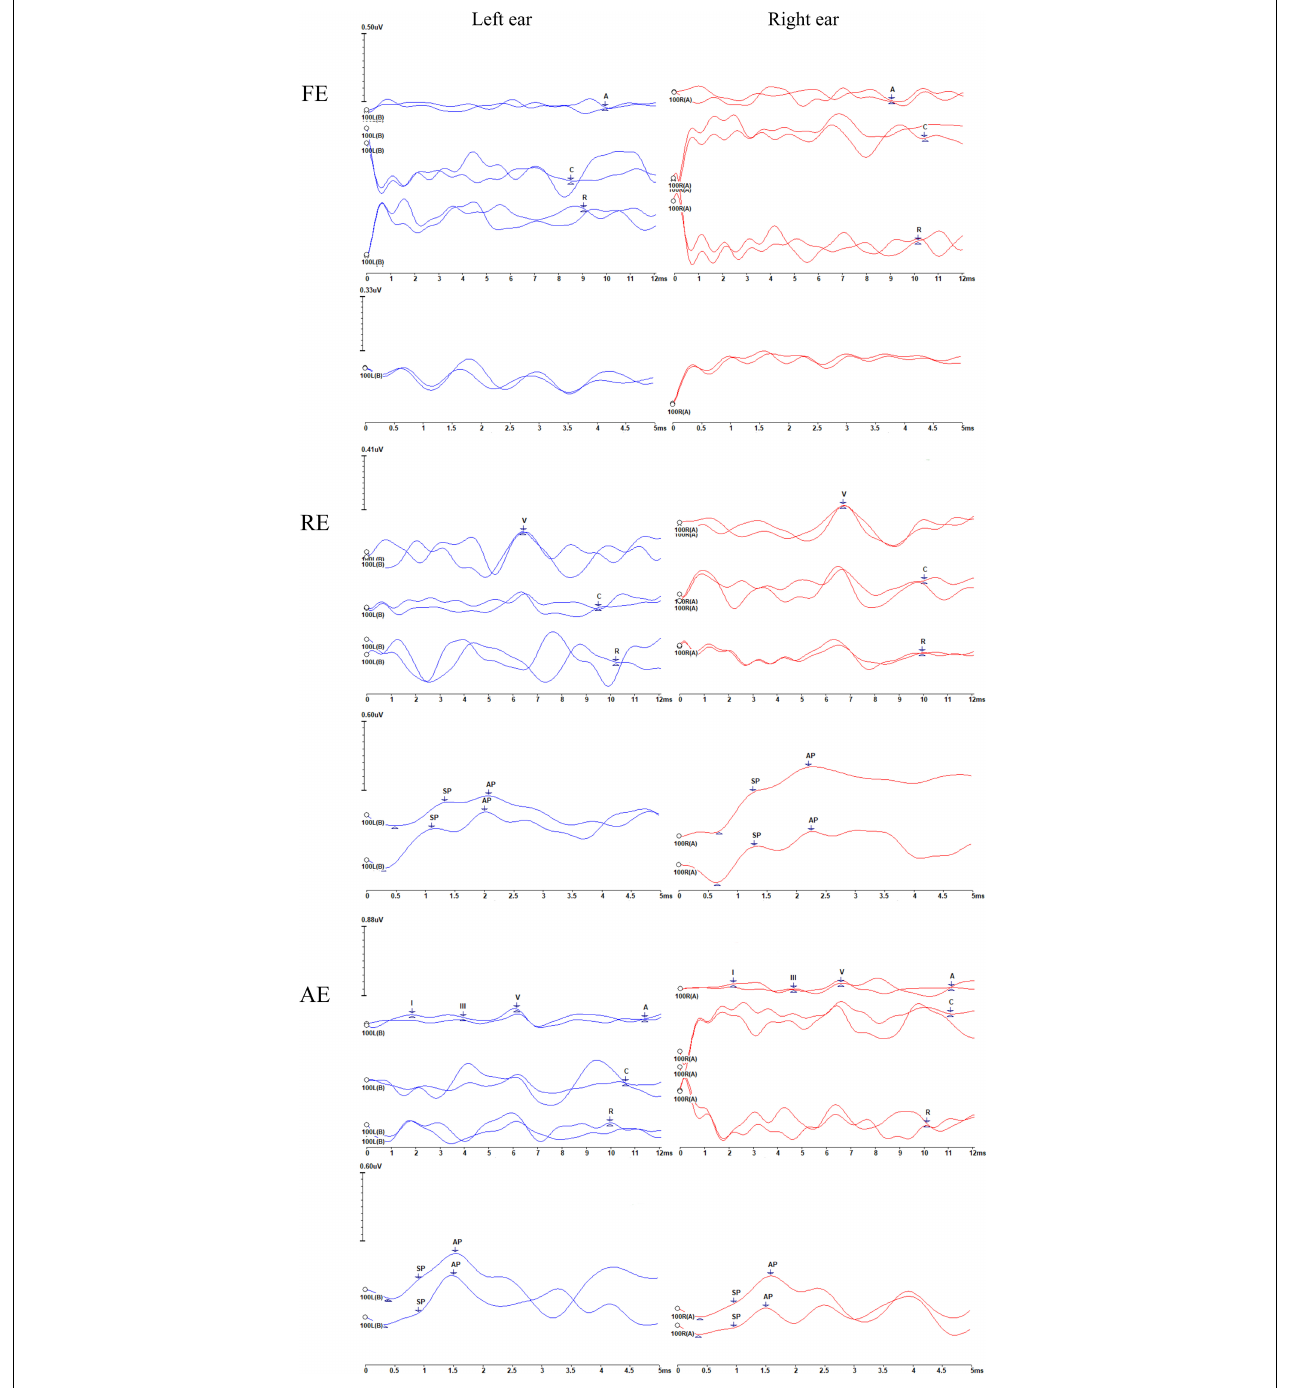
FIGURE 4 | Recordings of the auditory brainstem responses (ABRs), cochlear microphonics (CMs), and electrocochleography (ECochG) waveforms of the proband (II-4) during the three episodes. FE, febrile episode; RE, recovery episode; AE, afebrile episode. For each episode, the upper and lower panels represent the ABRs and CMs and ECochG signals, respectively. The number 100 indicates the click stimulus level. “A” indicates ABRs, and “C” and “R” represent the condensation and rarefaction polarity click responses, respectively. CMs can be identified according to the inverted phases of C and R responses. Waves I, III, and V are marked. The changes in ABRs and CMs differ. ABRs were gradually restored, i.e., absent (FE), then abnormal (with an elevated threshold and prolonged latency) (RE), and finally, almost normal (AE). However, CMs were persistently present, although some were of low amplitude. AP and SP represent the action potential and summating potential, respectively. ECochG signals were absent under febrile conditions (FE). Notably, the results appear show neuroelectric activity and possibly the CMs rather than ECochG. During the RE, the SP/AP amplitude ratios were > 0.4. During the AE, the SP/AP amplitude ratios were < 0.4, indicating a recovery of auditory function.